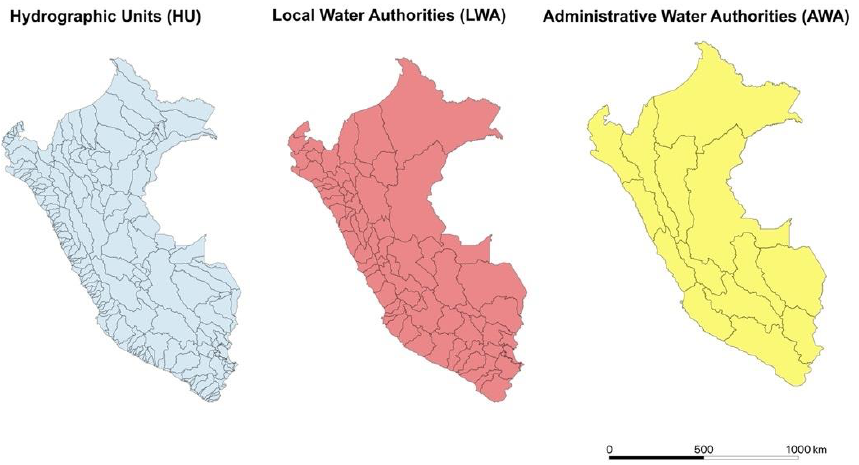
Figure 4 . The Hydrographic Units file (in blue) in Peru contains the files related to Water Resources Management at the local level (in red) and the regional levels (in yellow).